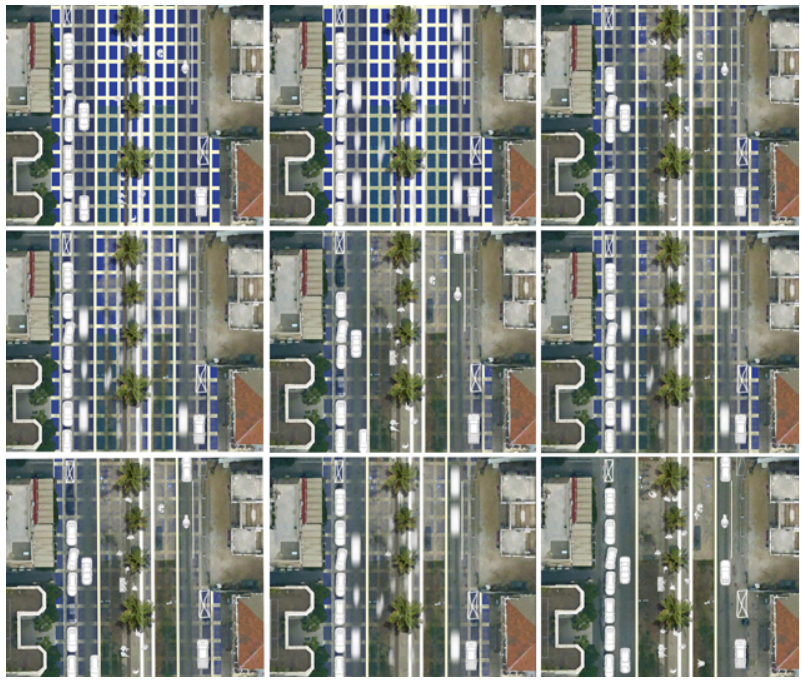
Top view of the intervention showing its gradual disappearance over time [cred - its: the